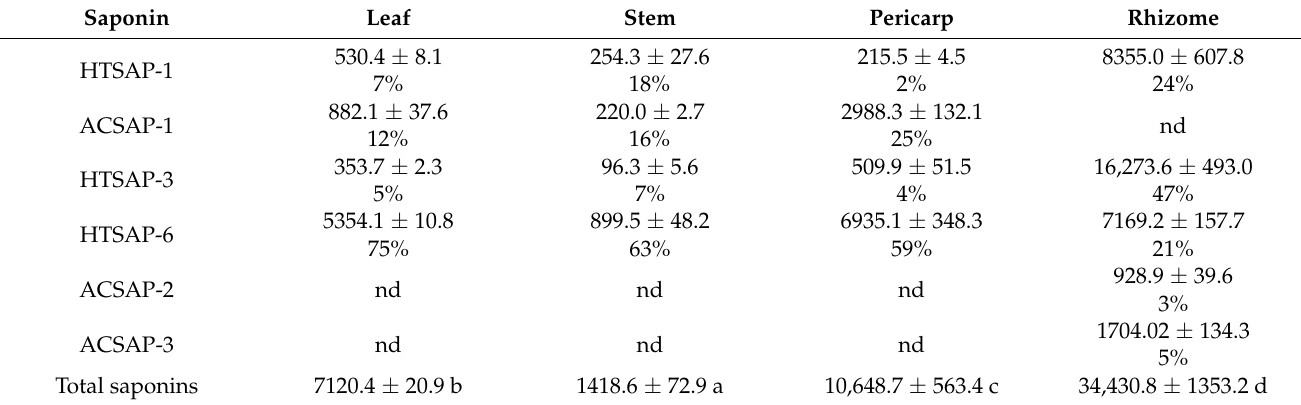
Table 3. Saponins identified in the leaf, stem, pericarp and rhizome ethanolic extracts of A. acutifolius , calculated from the molecular ion of the peak area obtained by HPLC-MS.